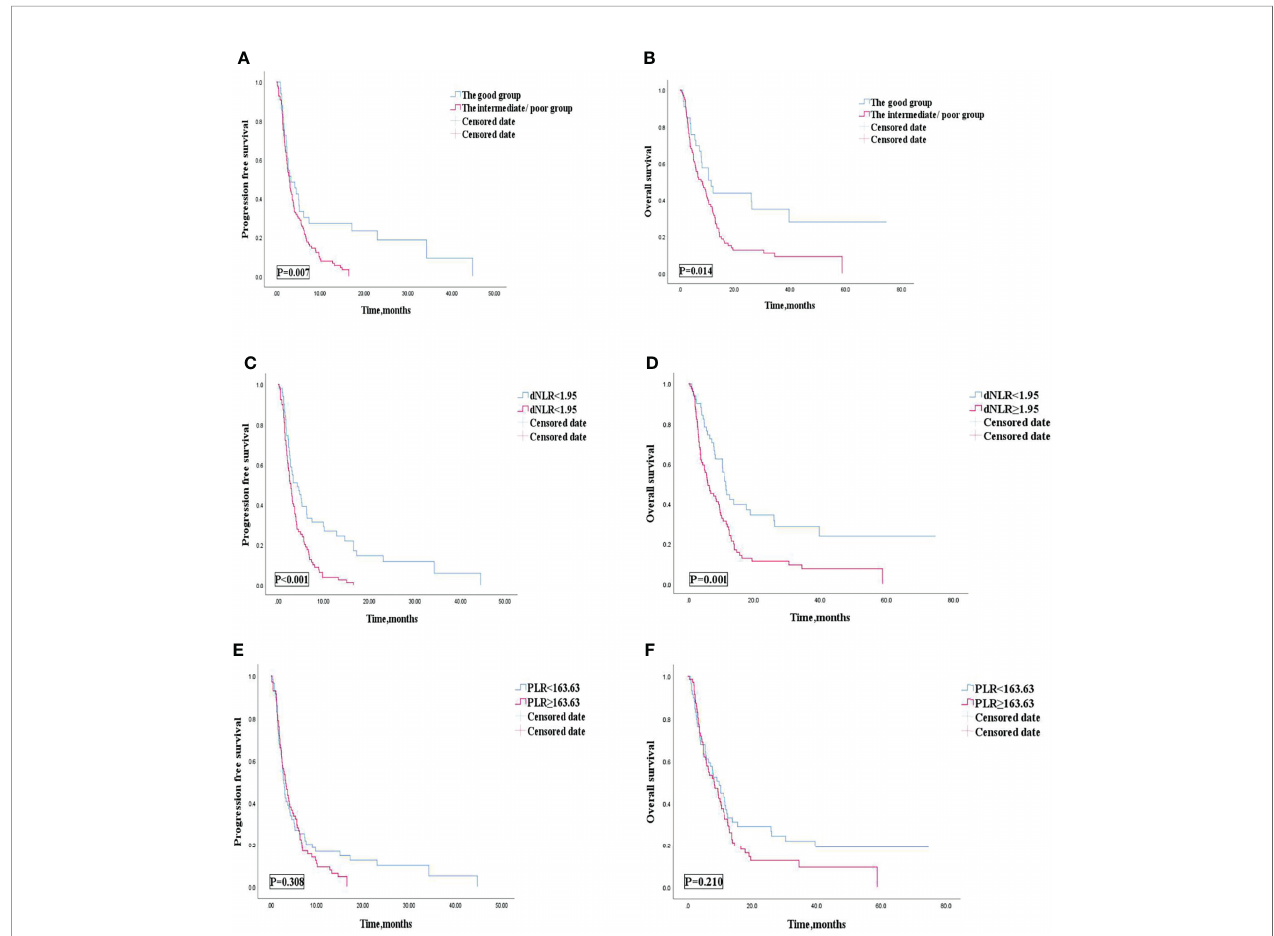
FIGURE 4 | PFS (A) and OS (B) of the good group and the intermediate/poor group of the multi-line of patients with AGC, receiving ICIs cohort, PFS (C) and OS (D) of the dNLR of the multi-line of patients with AGC, receiving ICIs cohort, and PFS (E) and OS (F) of the PLR of the multi-line of patients with AGC, receiving ICIs cohort. PFS, progression-free survival; OS, overall survival; ICIs, immune checkpoint inhibitors; dNLR, derived neutrophil ‐ to ‐ lymphocyte; PLR, platelet – lymphocyte